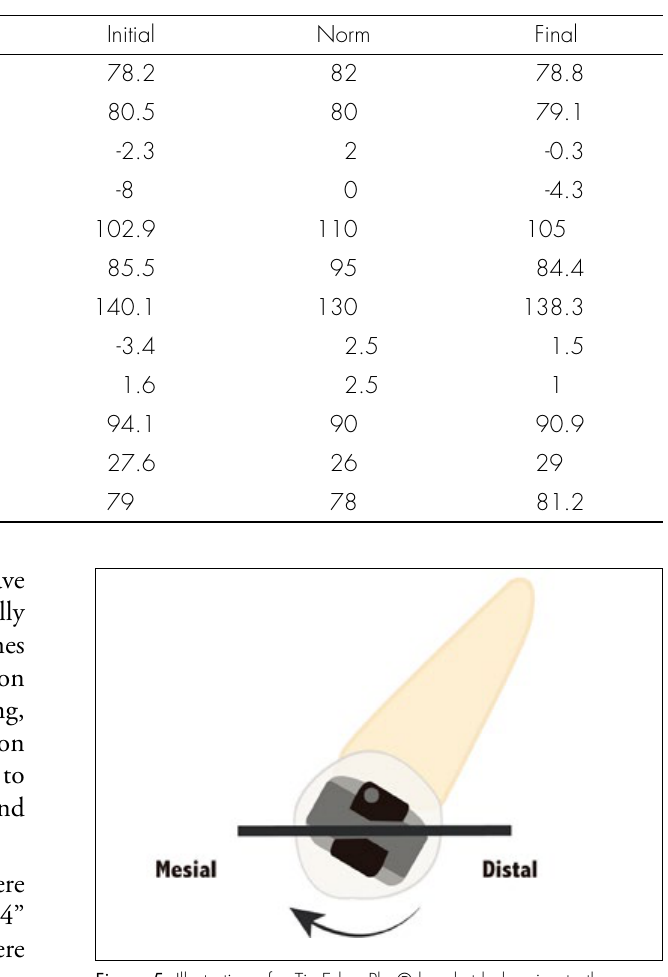
Figure 5. Illustration of a Tip-Edge Plus® bracket belonging to the upper right quadrant bonded on an upper left tooth to allow mesial